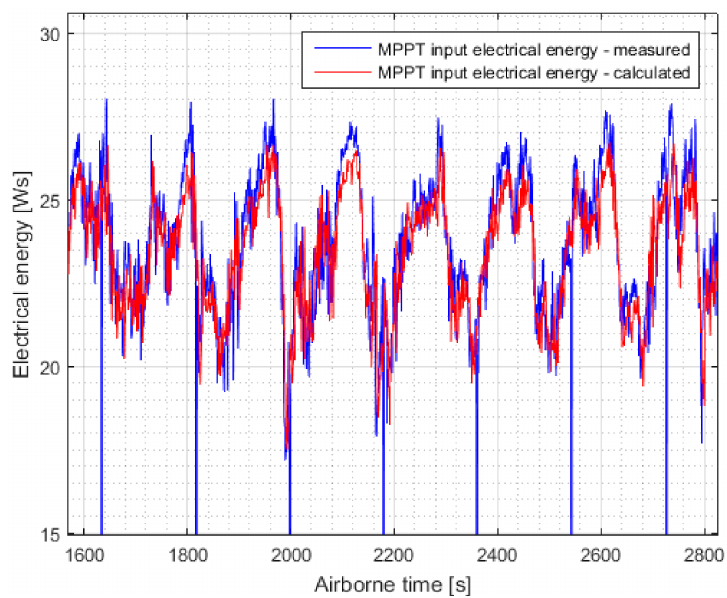
Figure 17. Comparison between the measured and calculated electrical energy values at the input of the MPPT during a short segment of the flight performed on 3 September